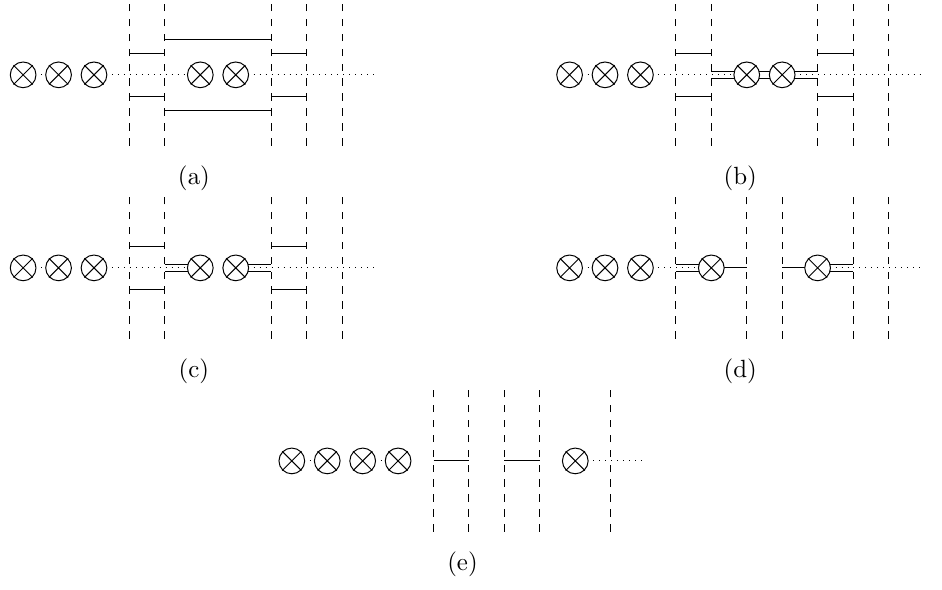
Figure 47. (cid:22) O KP transition from the closure of the subregular nilpotent orbit to the trivial (2 2 ) orbit of sp (2). (a) Higgs branch brane con(cid:12)guration of the initial system. (b) One focusses on the D3-brane in the middle interval. This brane is taken to the origin and split into three segments. (c) The middle segment can acquire non zero ~x position along the directions spanned by the half NS5- branes. The limit is taken where this position goes to in(cid:12)nity, e(cid:11)ectively removing the threebrane from the system. (d-e) An attempt to remove the (cid:12)xed segments of D3-branes from (c). During these phase transitions the remaining D3-branes that could have generated a new Higgs branch are also annihilated. The resulting Higgs branch is the trivial